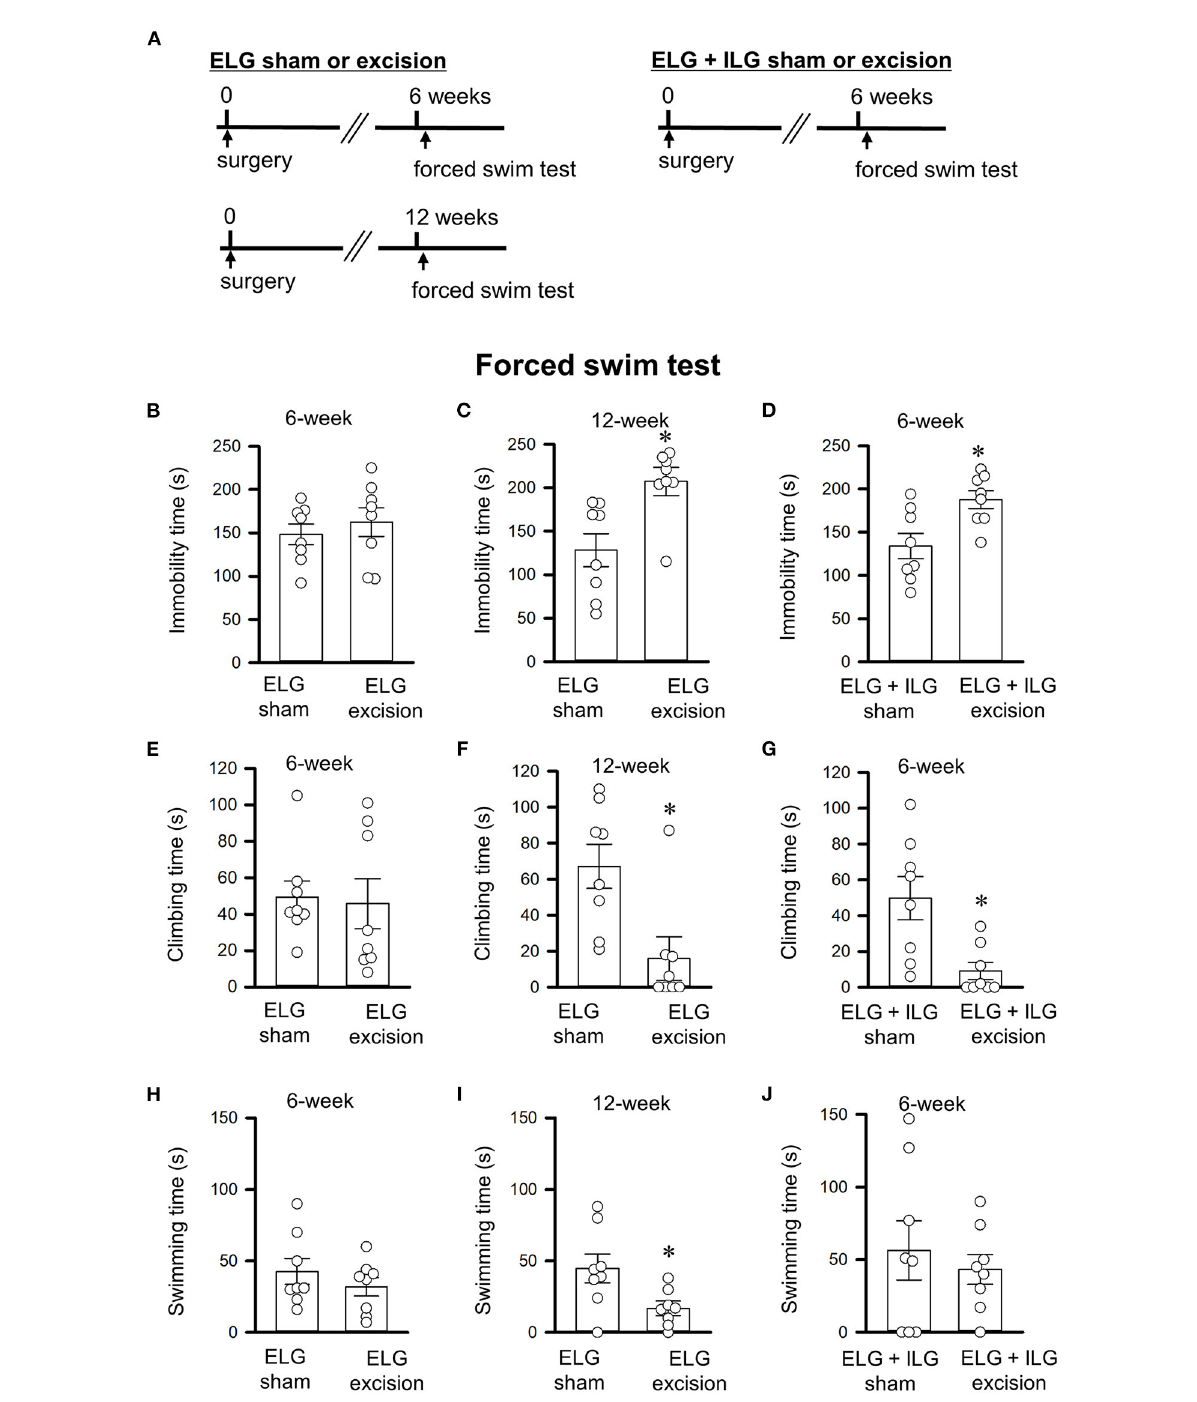
FIGURE2 Effects of lacrimal gland excisions on behavioral performance in the forced swim tests. (A) Timelines of the experimental procedure. (B–J) Total times of immobility (B–D) , climbing (E–G) , and swimming (H–J) for 4 minute durations in the forced swim test. (B,C,E,F,H,I) Tests were performed on ELG excision and sham-operated mice at 6 weeks (B,E,H) and 12 weeks after surgery (C,F,I) . (D,G,J) Tests were performed on ELG + ILG excision and sham-operated mice at 6 weeks after surgery. Each column and the corresponding vertical bar represent the mean ± SEM ( n = 8); open circles indicate individual values. * P < 0.05 vs . the sham-operated